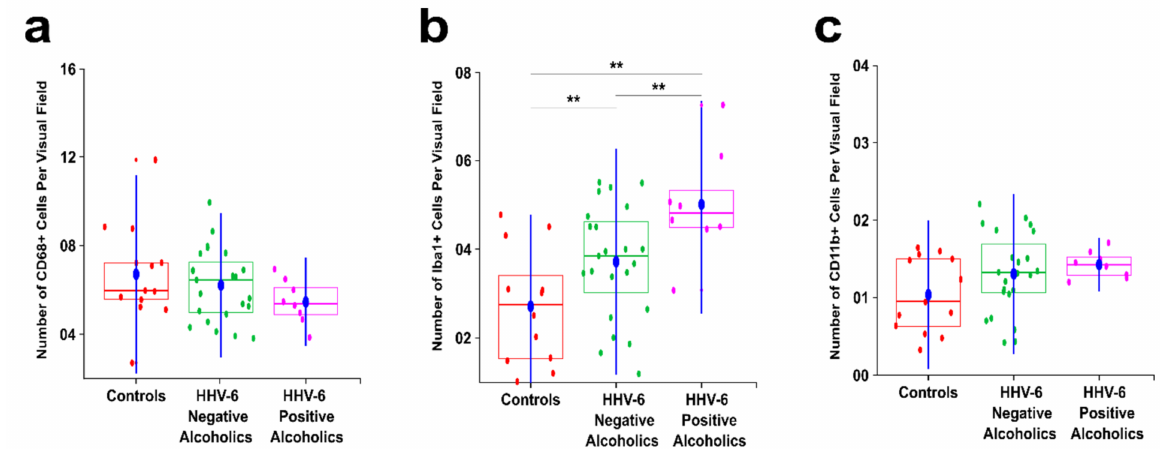
Figure 11. Intergroup analysis between HHV-6 positive alcoholics, HHV-6 negative alcoholics, and controls. The blue dot indicates the mean of the respective group. Red color indicates controls, green color indicates HHV-6 negative alcoholics and pink color indicates HHV-6 positive alcoholics. ** indicates a significant difference between the groups (Kruskal Wallis ANOVA p < 0.05 with Bonferroni correction is considered significant). ( a ) Boxplot showing the average number of CD68+ cells per visual field in the SN region; ( b ) Boxplot showing the average number of Iba1+ cells per visual field in the SN region; ( c ) Boxplot showing the average number of CD11b+ cells per visual field in the SN